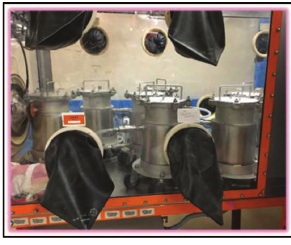
Fig. 19. Leaching test.